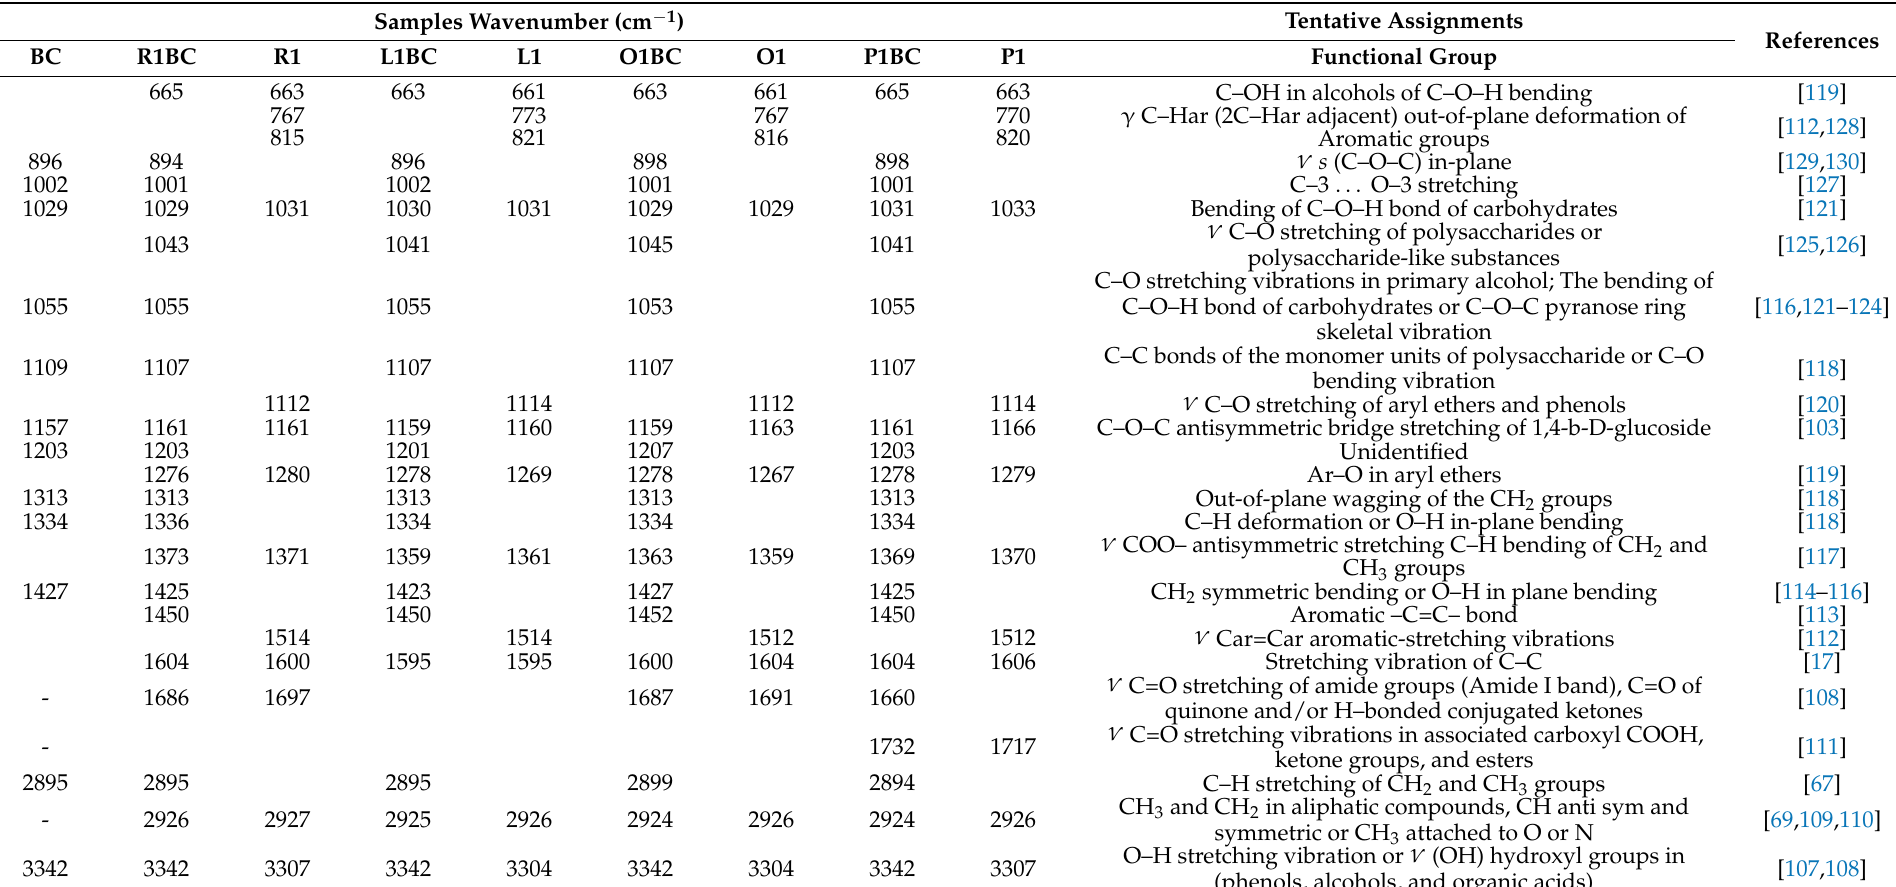
Table 5. Tentative assignments of some functional groups on bacterial cellulose (BC), bacterial-cellulose pellicles enriched with ethanolic extracts of rosemary (R1BC), lovage (L1BC), oregano (O1BC), and parsley (P1BC) and ethanolic extracts of rosemary (R1), lovage (L1), oregano (O1), and parsley (P1) by FT-IR.